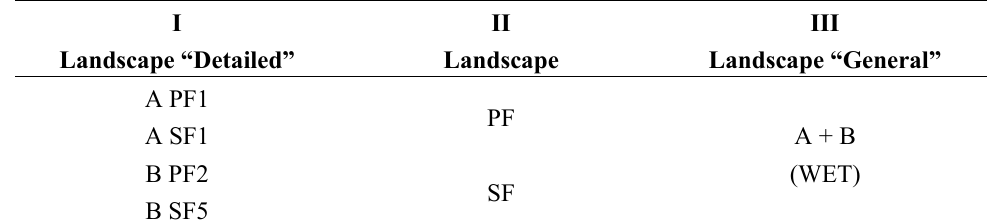
II III Landscape Landscape “General” PF A + B (WET) SF